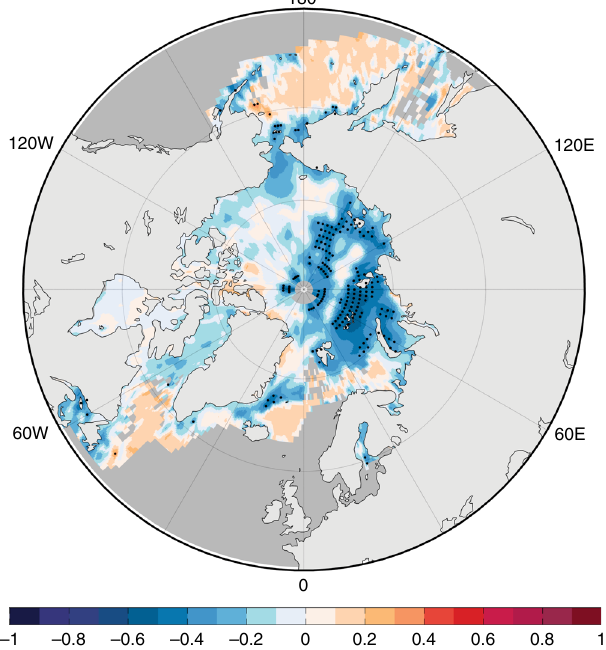
Fig. 6 Relationship between the z500 extremes index and sea ice. Partial correlation coef fi cients between the December – March z500 extremes index and preceding November SIC anomalies after linearly removing the in fl uence of ENSO, volcanic AOD, and time trend. Stippling indicates statistically signi fi cant correlations at the 5% signi fi cance level